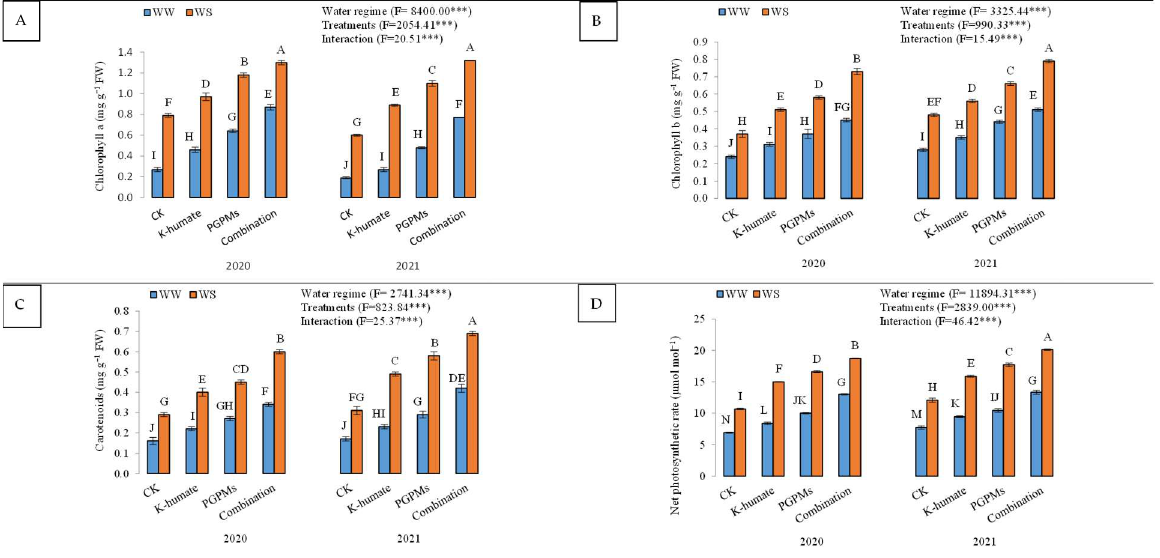
Figure 2. Changes in ( A ) chlorophyll a (chl a); ( B ) chlorophyll b (chl b); ( C ) carotenoids contents, and ( D ) net photosynthetic rate in soybean seeds ( Glycine max L. cv. Giza 111) leaves, which were cultivated in salt-affected soil and treated with plant growth-promoting microbes (PGPMs; Bradyrhizobium japonicum ( USDA 110) and Trichoderma harzianum ), potassium humate (K-humate), and their combination under two water regimes (WS: water deficit regime and WW: well-watered regime) during two consecutive seasons. Different letters above columns show significant differences between treatments according to the Tukey’s test ( p ≤ 0.05). Data are Means ± SD and n = 3. *** denotes significance at p ≤